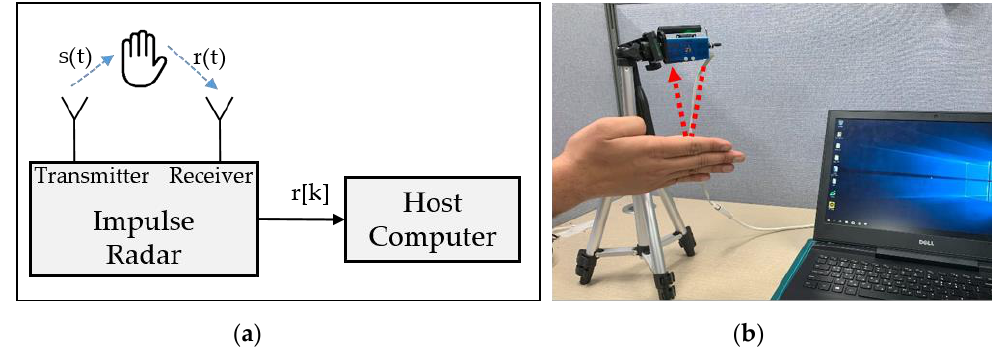
Figure 2. Data acquisition setup: ( a ) Conceptual setup and ( b ) its corresponding actual hardware setup.